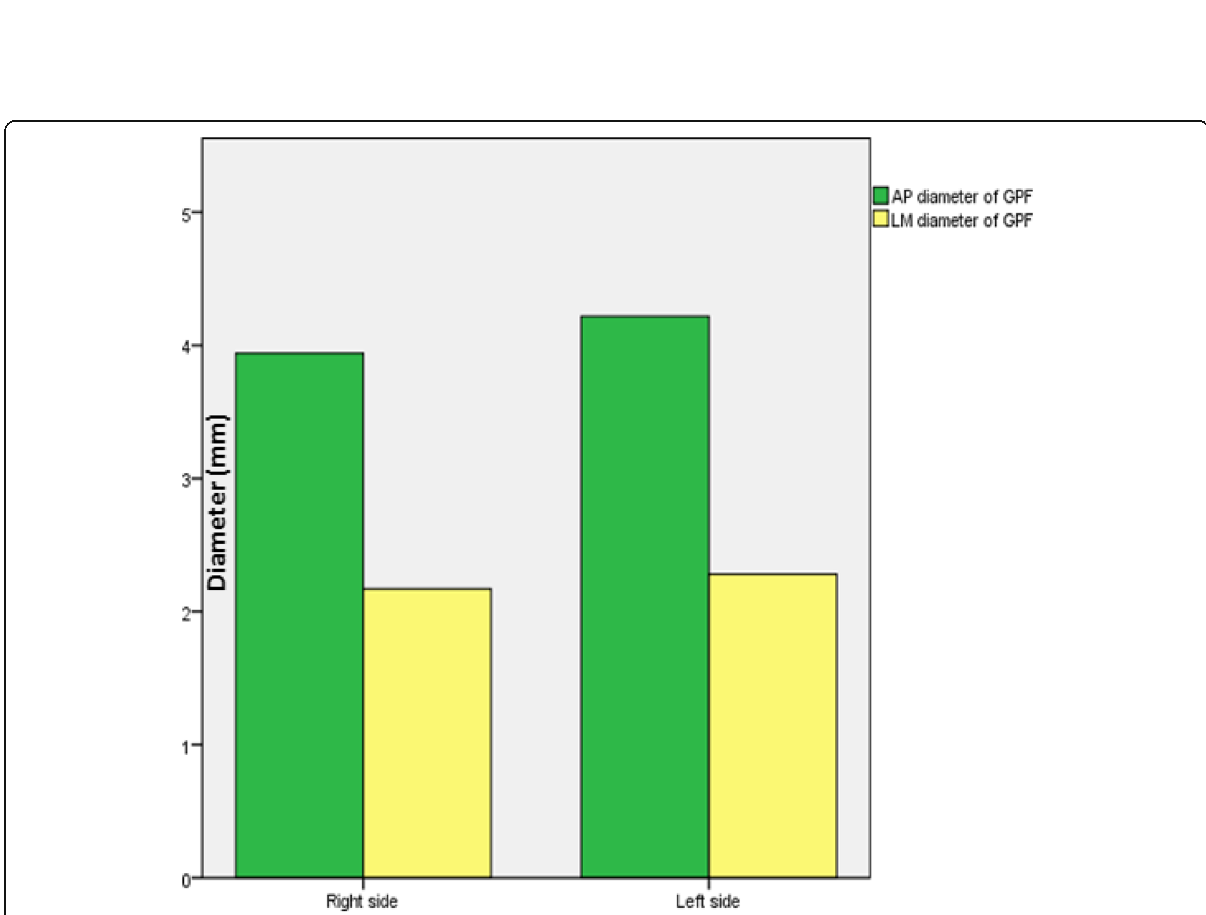
Fig. 7 Bar chart of the dimensions of the greater palatine foramen (GPF) in CT scans based on